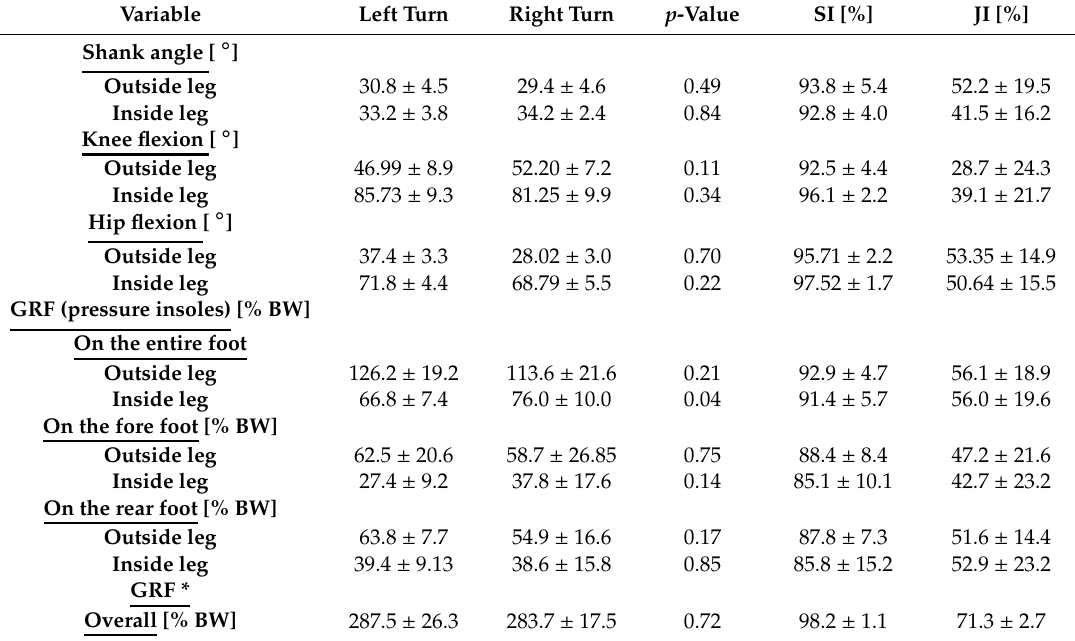
Table 1. The inclination, flexion of the joints and ground reaction forces (GRF) acting on various parts of the legs during the steering phase of left and right turns by elite slalom skiers, together with the corresponding symmetry (SI) and Jaccard (JI) indices (independent variables). All values presented are means ± standard deviations. Variable Left Turn Right Turn p